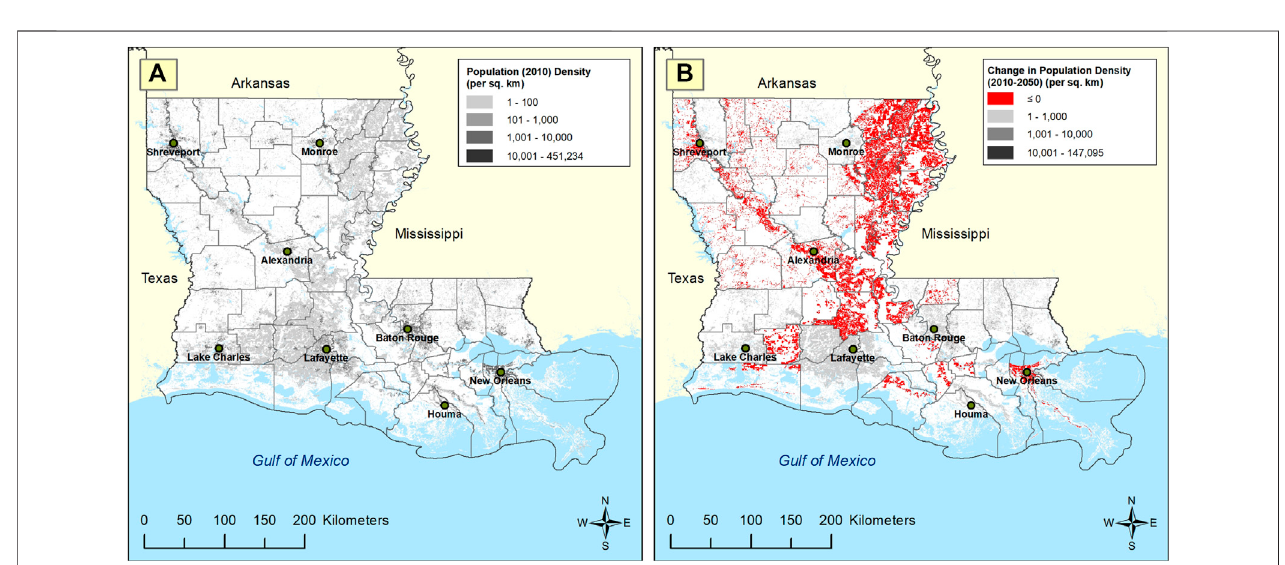
FIGURE 2 | Population density by Louisiana census block: (A) 2010, and (B) projected change from 2010 to 2050.